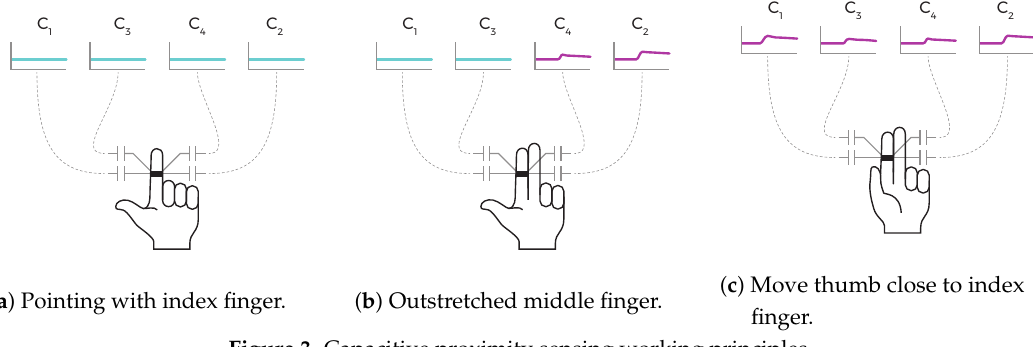
Figure 3. Capacitive proximity sensing working